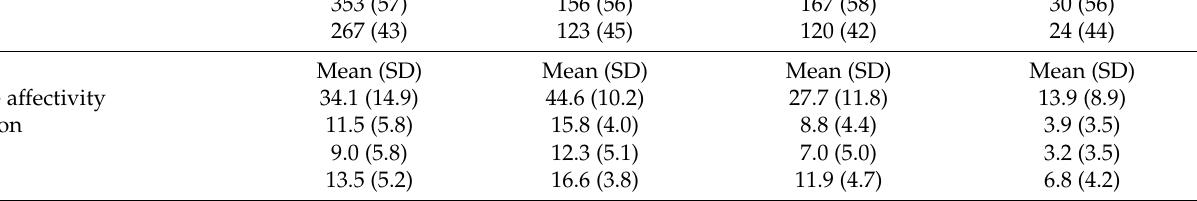
respectively. Cronbach’s α coefficient of the SOC-13 was 0.944, and the Cronbach’s α coefficient of the social support dimensions were: material ( α = 0.846), affective ( α = 0.880), emotional ( α = 0.923), positive social interaction ( α = 0.938) and information ( α = 0.920). Demographic characteristics, socioeconomic status, social distancing factors and psy- chosocial factors are presented for the total sample and according to GHQ-12 groups in Table 1. The average age of the participants was 23.0 (SD = 3.7). The majority of partici- pants were females (78%), admitted through social quotas and from families with monthly income up to 3 BMWs. Most students experienced reduction of family income during the social distancing period, did not work during the social distancing period and were offered non-mandatory online modules during the interruption of the academic semester. The mean scores for psychological well-being, negative affectivity, SOC, and social support were 25.9 (SD = 7.2), 68.2 (SD = 29.8), 37.0 (SD = 8.2) and 57.1 (SD = 17.1),